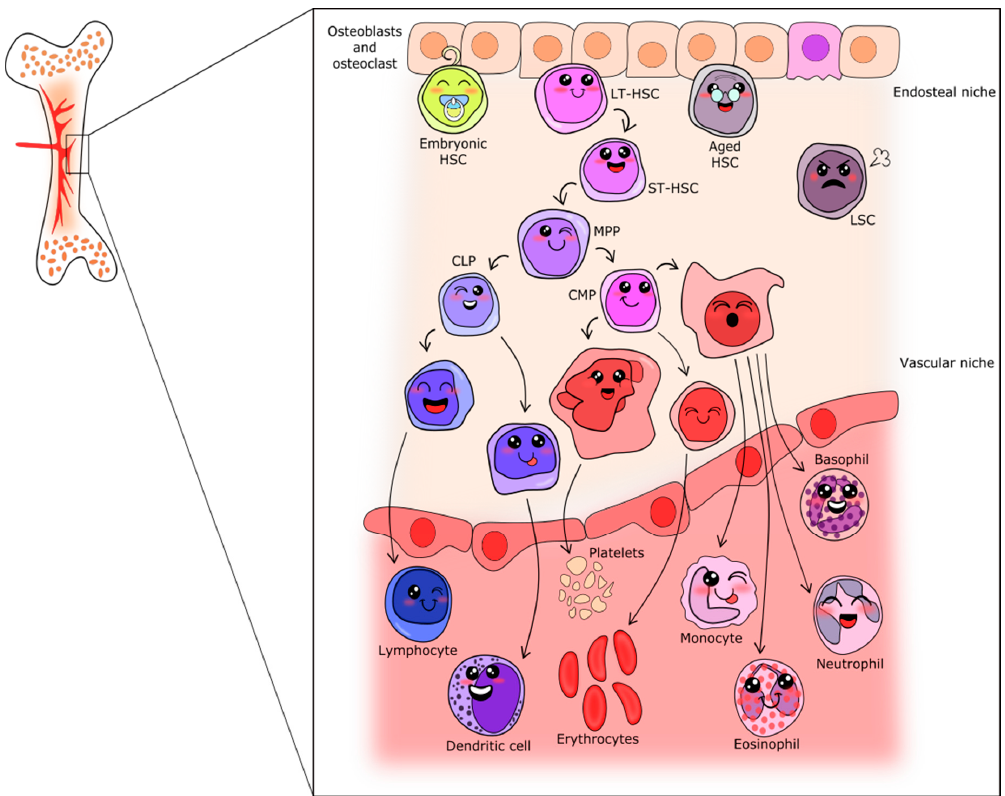
Figure 1. Schematic representation of the classical hierarchic model of hematopoiesis. From the endosteal niche (upper part of figure) to the blood vessel, passing through the vascular niche, the following distinct populations are depicted: LT-HSC—Long-term hematopoietic stem cells; ST-HSC—Short-term hematopoietic stem cells; LSC—leukemic stem cells;